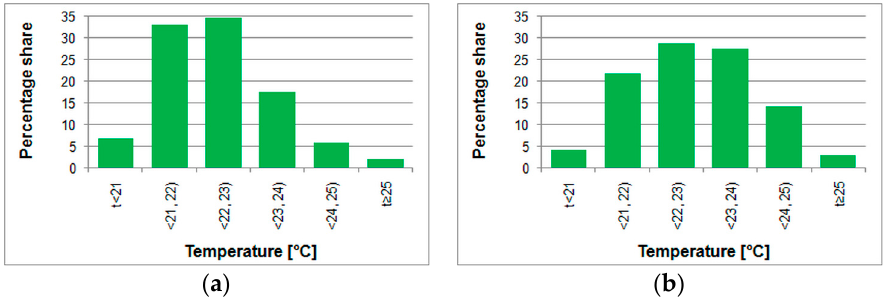
Figure 15. Average air temperature histograms: ( a ) all days; ( b ) working days only. These figures prove the important feature of radiant heating and cooling systems which is the uniform temperature profile from a floor to a ceiling, typical for the TABS systems [34]. The difference between T9 and T0 temperatures during the analysed period (working hours only) was from − 0.93 °C to 6.28 °C (Figure 16a). Dominating share (Figure 16b) had values between − 0.5 °C and 1.5 °C (81.6%).